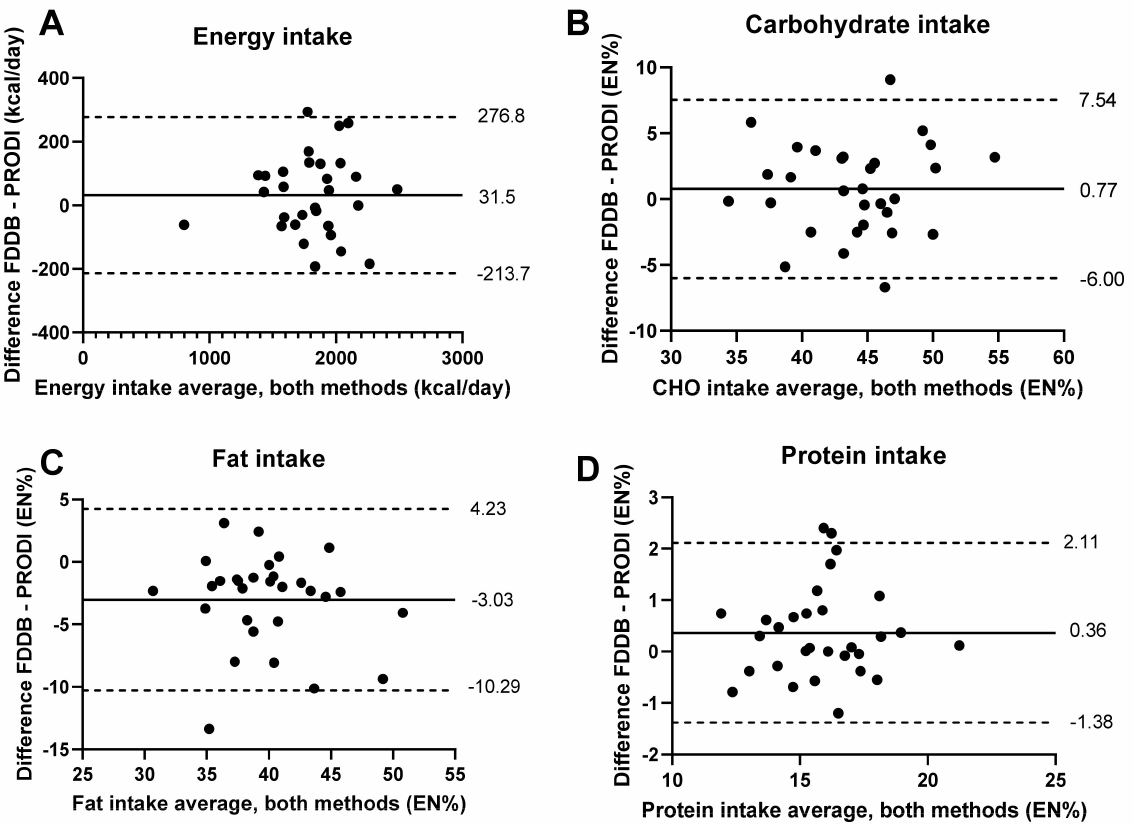
Figure 2. Repeated-measures Bland-Altman plots of the differences in intakes analyzed using the FDDB and PRODI tools against the mean values for the two methods for ( A ) energy, ( B ) carbohydrates, ( C ) fat, and ( D ) protein. The solid line indicates the mean difference, while the dashed lines indicate the 95% limits of agreement (LOAs) (1.96 SD) for nutrient intake. EN%, relative percentage energy intake of total macronutrient